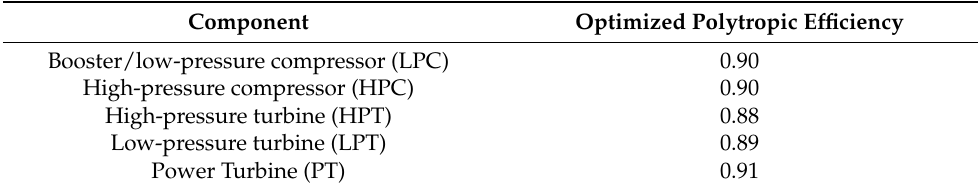
Table 7. Component polytropic efficiency.